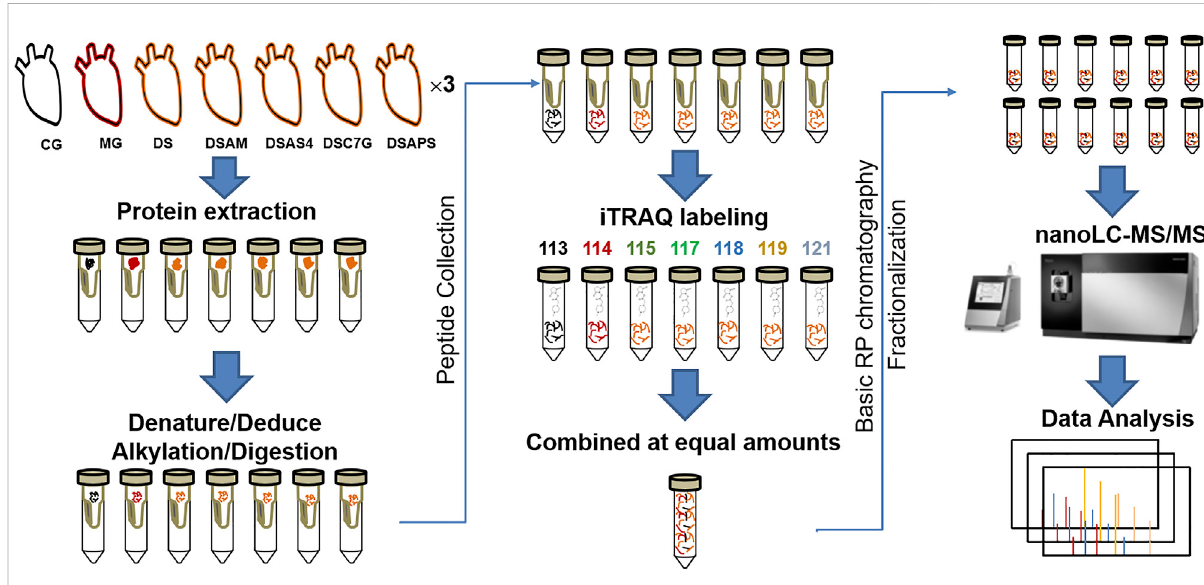
FIGURE 1 Work fl ow of quantitative proteomics analysis. The heart tissues of rats from seven groups are designated as the control group (CM), ISO-iCM model group (MG), and treated groups with Descurainia sophia seed decoction alone (DS), and combined with Astragalus mongholicus (DSAM), astragaloside IV (DSAS4), astragalus calycosin-7-glucoside (DSC7G), or astragalus polysaccharides (DSAPS),